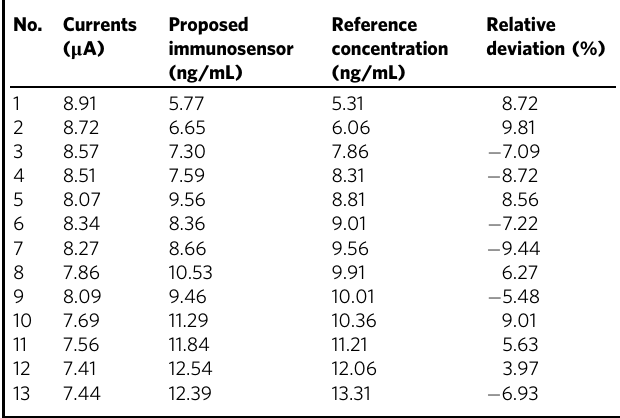
Table 1 Assay results of clinical serum samples using the proposed VEGF-C immunosensor and a commercial instrument.